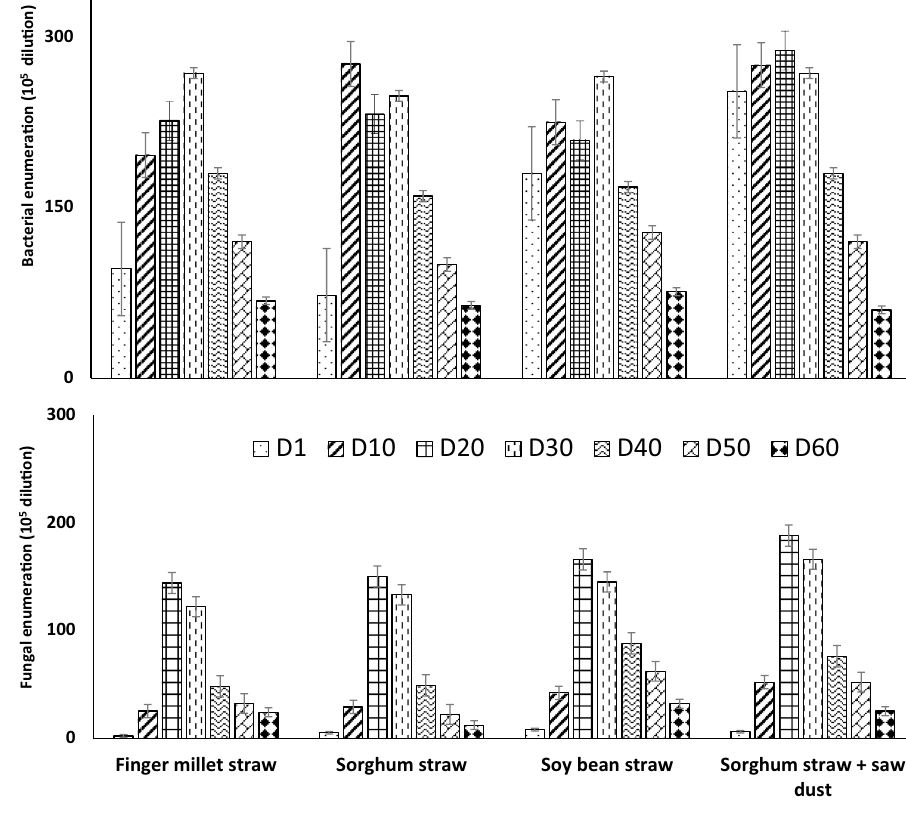
Fig. 5 Microbial activity profile during the composting of finger millet straw, sorghum straw, soybean straw and sorghum straw + saw dust during the composting